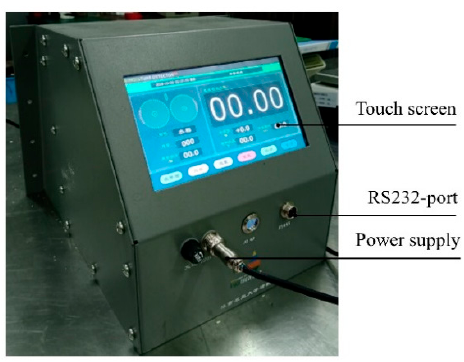
Figure 12. The actual view of the single grain moisture content online measurement device.